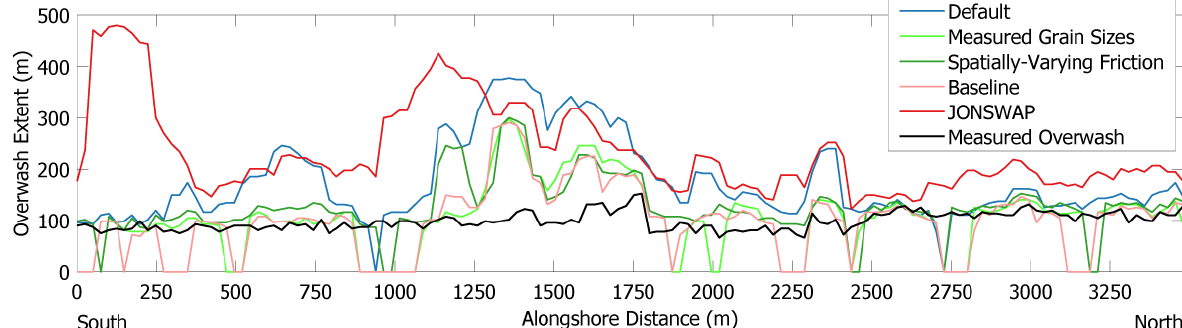
Figure 6. NGS post-Florence imagery ( A ) and outlined overwash deposits for the default simulation ( B ), grain size simu- lation ( C ), spatially varying friction simulation ( D ), baseline simulation, ( E ) and JONSWAP simulation ( F ) at the south- ern/central section of Masonboro Island. Erosion is shown in red, and deposition is shown in blue. The green outline is the overwash polygon for each respective simulation.